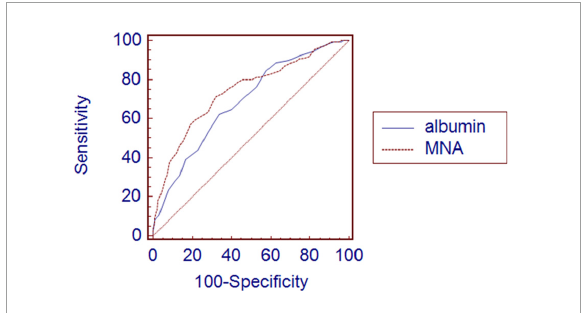
FIGURE3 Comparison of area under receiver operating characteristic curve between albumin and MNA for 3-month all-cause mortality after discharge. Graph shows higher AUC in